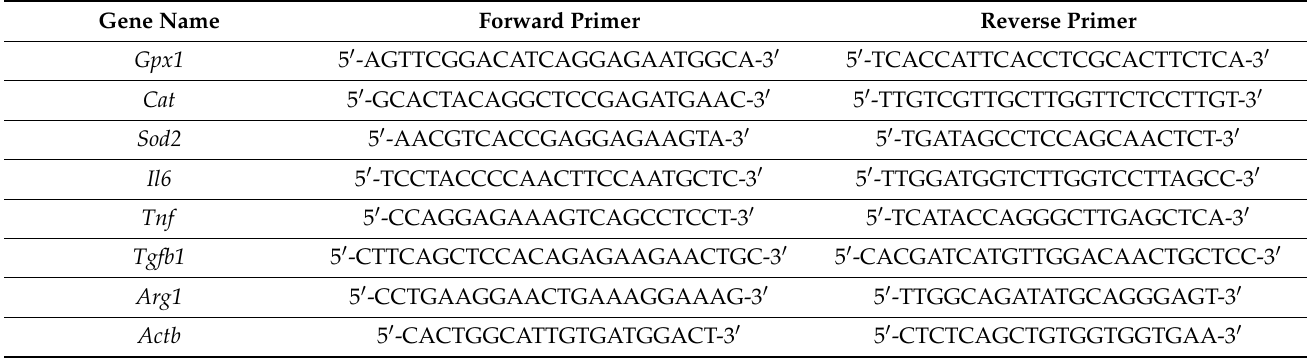
Table 1. List of primer sequences used in real-time